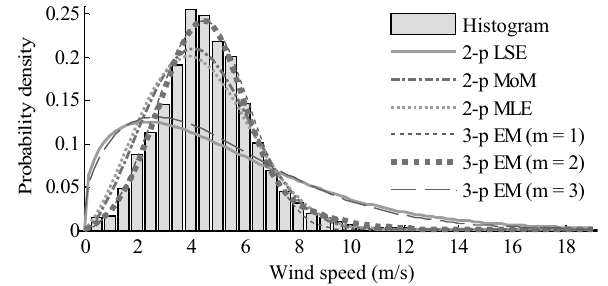
Figure 1. Histogram of wind speeds. The bin size of wind speed interval is 0.5 m/s. The bold dotted line of two-component three-parameter Weibull mixture distribution with EM algorithm (3-p EM, m = 2) gives the